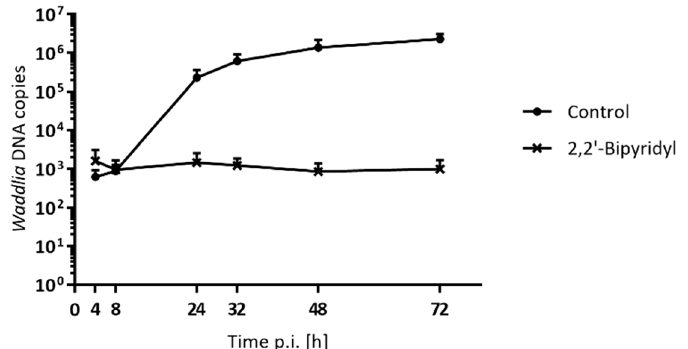
Figure 6. Treatment with 2,2 ′ -bipyridyl impacts Waddlia DNA replication. Number of DNA copies was quantified by qPCR in Waddlia -infected Vero cells treated with 100 μ M 2,2 ′ -bipyridyl at 2 hpi. Error bars represent the SD of two independent experiments. Values at 48 and 72 hpi in presence of 2,2 ′ -bipyridyl are significantly different to the untreated condition, as determined by the one-way ANOVA test.